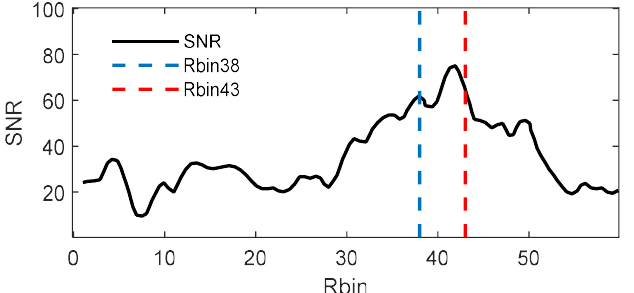
Figure 9. Range bin profile of the “La Viña” building campaign. Dashed blue and red lines enclose the Rbins between Rbin38 and Rbin43.